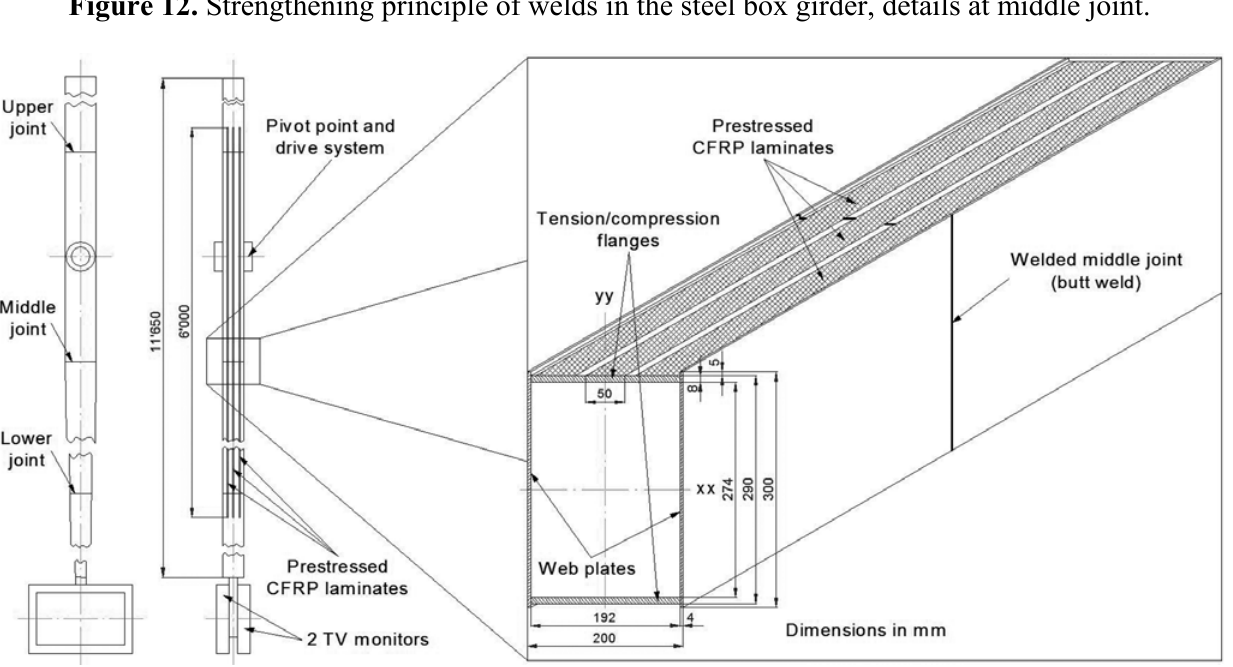
Figure 12. Strengthening principle of welds in the steel box girder, details at middle